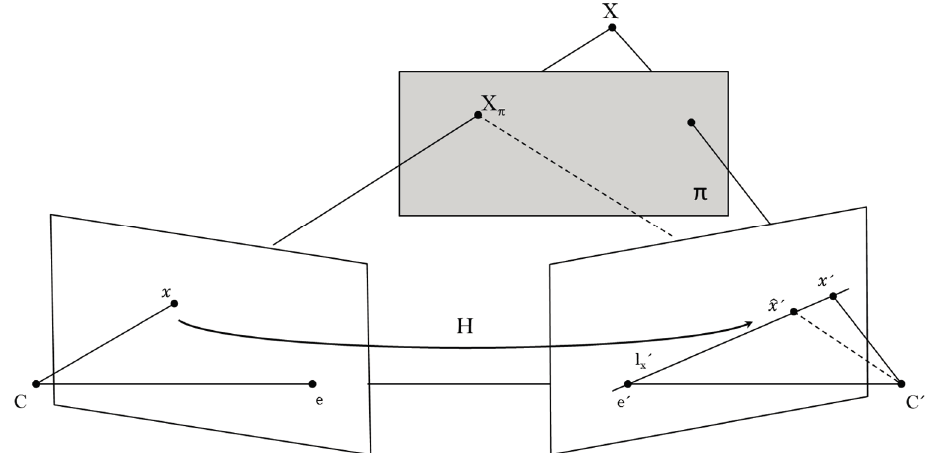
Figure 2. Plane induced